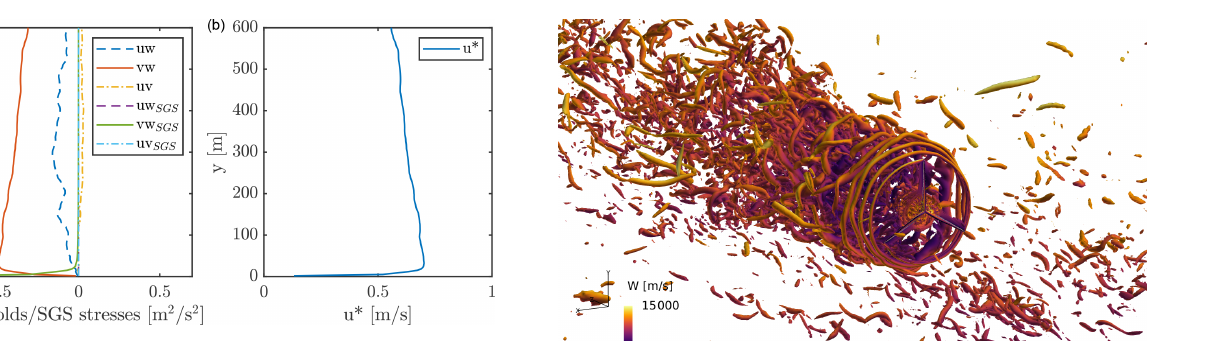
Figure 8. Precursor results: (a) horizontal averages of resolved and SGS shear stresses at 9250s and (b) resulting resolved friction ve- (cid:112) vw 2 + uv 2 . locity ( u ∗ ) 2 =